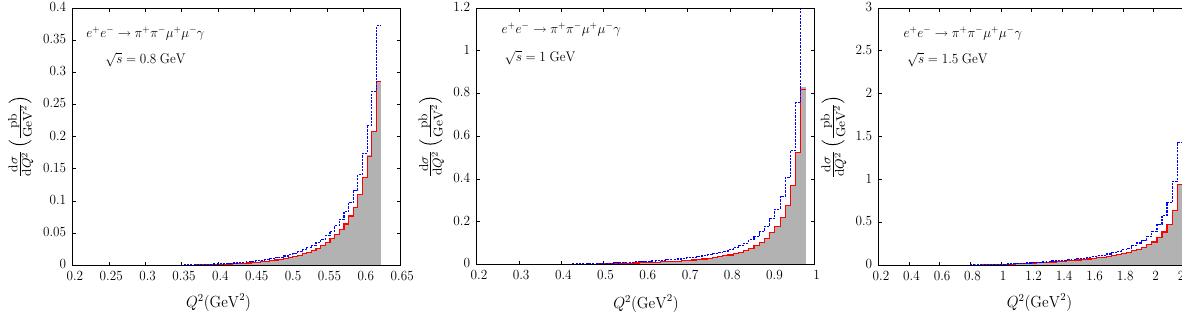
e + e − → π + π − π + π − γ √ s =0 . 8GeV